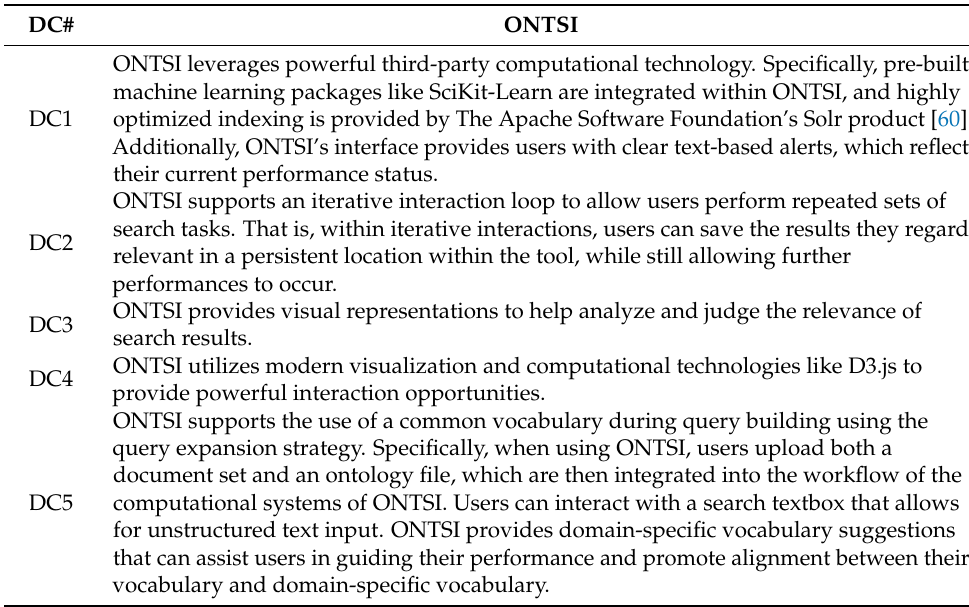
Table 3 highlights the role of each criterion in the design of ONTSI. Table 3. The role of each criterion within the design of ONTSI. The incorporation of these criteria in ONTSI’s implementation is discussed within the workflow and usage